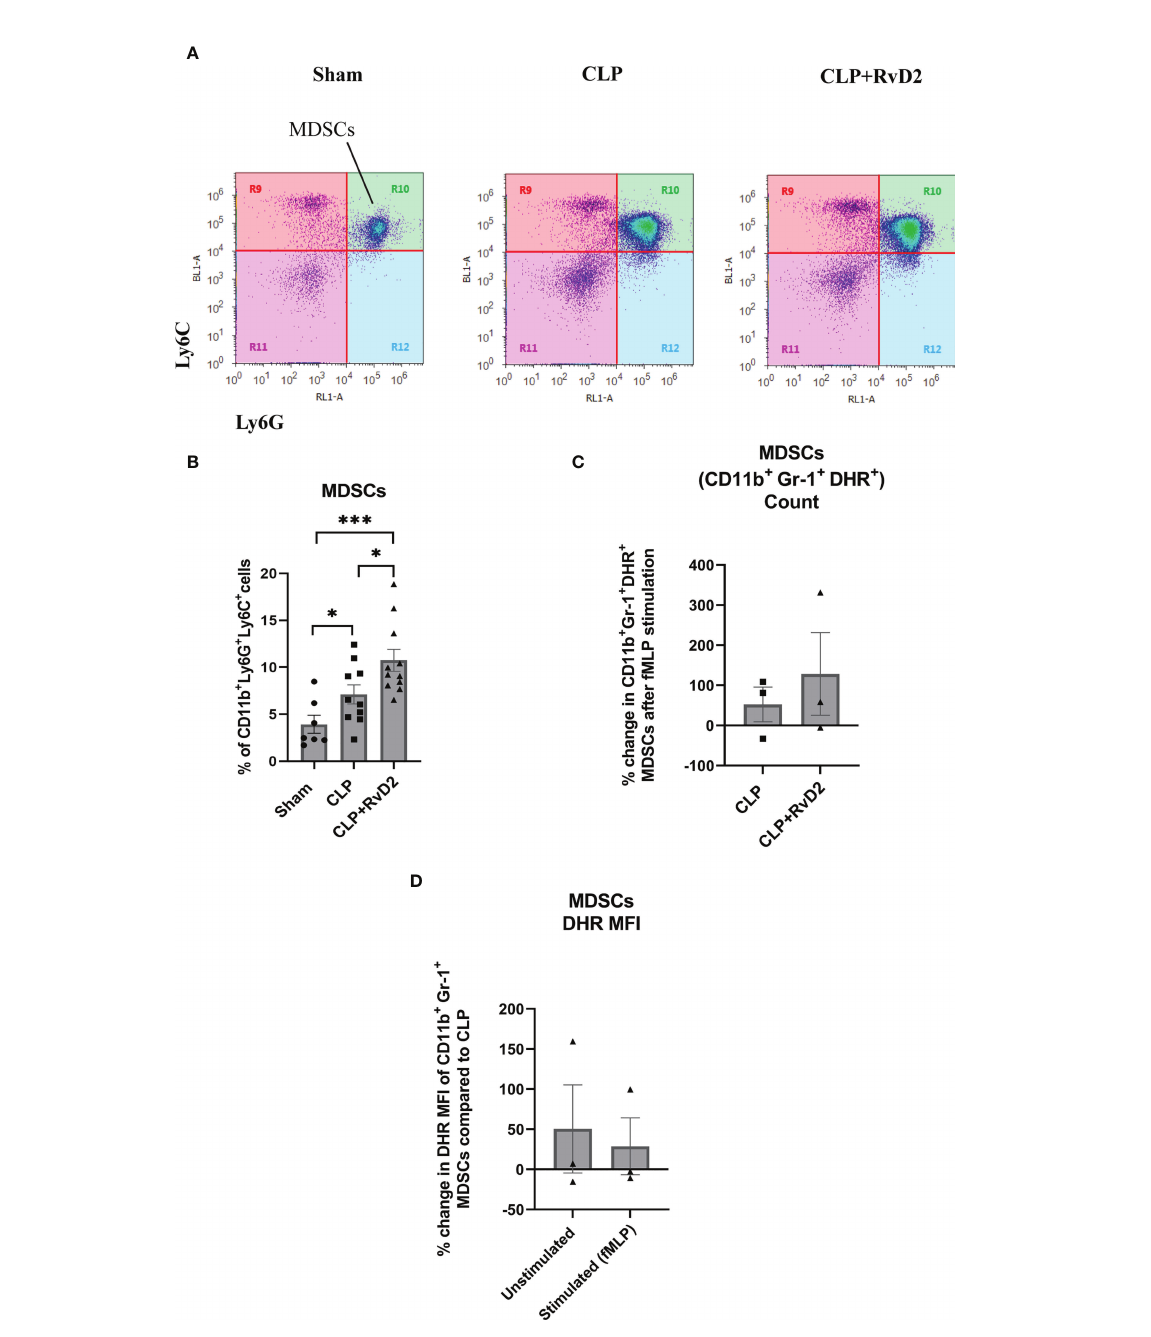
FIGURE 5 (A) CLP mice were given vehicle saline or RvD2 48h after surgery. Mice were sacri fi ced 24h later and spleen samples were taken. Myeloid- derived suppressor cells (MDSCs: CD11b + Ly6C + Ly6G + ) were identi fi ed as shown. (B) Cells from Sham, CLP, and CLP + RvD2 groups were quanti fi ed. Splenic MDSC numbers were increased after CLP and RvD2 administration increased the numbers even further. All data are mean ± S.E.M. *P<0.05, *** P < 0.001 for n = 7-11 in all groups. (C) In separate experiments, the percentage change in the number of fMLP stimulated ROS producing MDSCs (CD11b + Ly6G + Ly6C + DHR + ) was counted for cells from CLP and CLP+RvD2 mice. RvD2 had no effect on the number of MDSC stimulated cells. (D) The percentage change in median fl uorescence intensity (MFI) in ROS producing CD11b + Ly6G + Ly6C + DHR + cells (basal and stimulated) between CLP + RvD2 treated mice cells and cells from CLP mice was measured. RvD2 did not affect the MFI of ROS producing